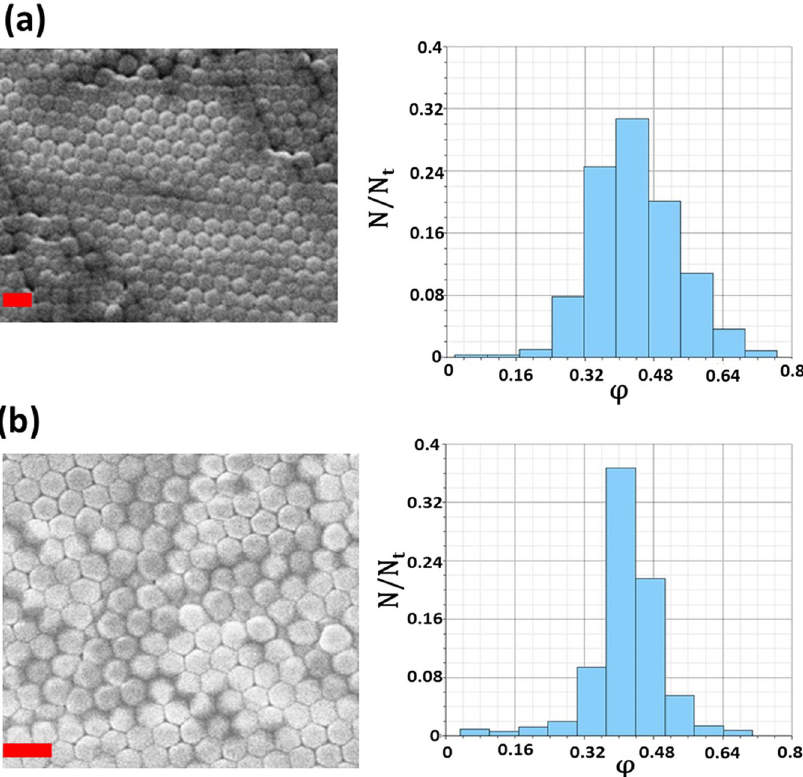
Figure 7. Particle arrangement and defects. SEM micrographs and histograms indicating the void fractions ( ϕ ) for ( a ) unconfined ( b ) confined droplet. Here each particle (N) is considered as a bin and void fraction is calculated for each bin. N t is the total number of particles. Scale bar equals 400 nm. 200 nm particles are used to study the effect of confinement on particle